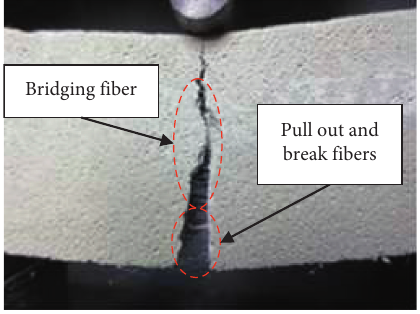
Figure 22: “Bridging” phenomenon of fibers in cast-in-situ foamed concrete fiber. Table 9: Flexural strength results of polypropylene fiber cast-in-situ foamed concrete (unit: MPa). Fiber content